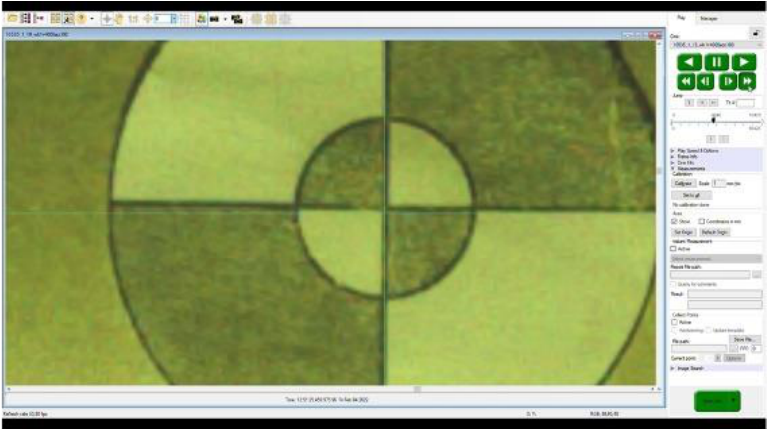
Figure 22. Measurement of vertical displacement of marker for V4000 and ACC100 parameters. Result: d=0.4243 mm; s=0.0005 m/s; a= 1.5708 rad; as= 1.8513 rad/s.